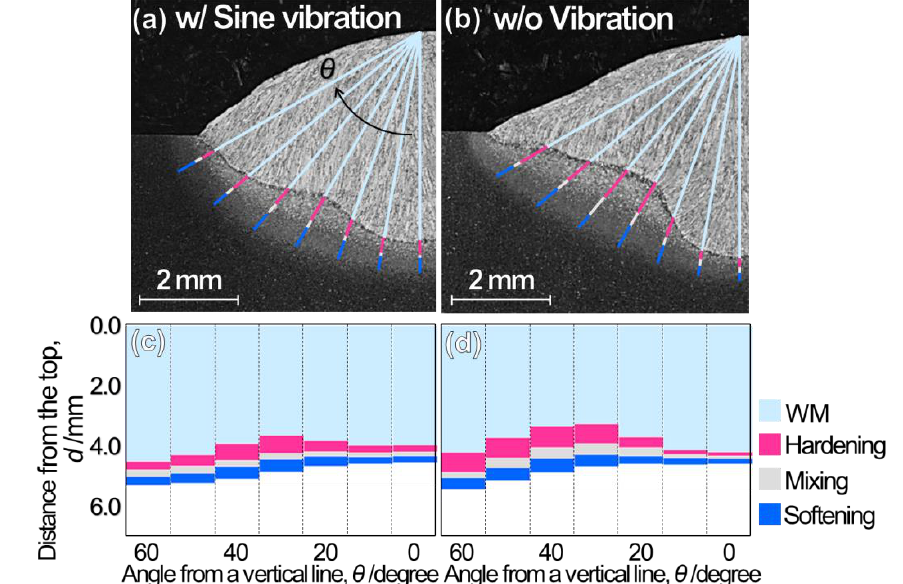
Figure 5. Cross-sectional ( a ), ( b ) OM images and ( c ), ( d ) bar charts of specific weld metal (WM) and heat-affected zone (HAZ) area thickness for TP-GMAW specimens at 1.2 m/min ( a ), ( c ) w/ and ( b ), ( d ) w/o sine vibration (F = 250 Hz, G = 1.2 m/s 2 and T = 30 s).